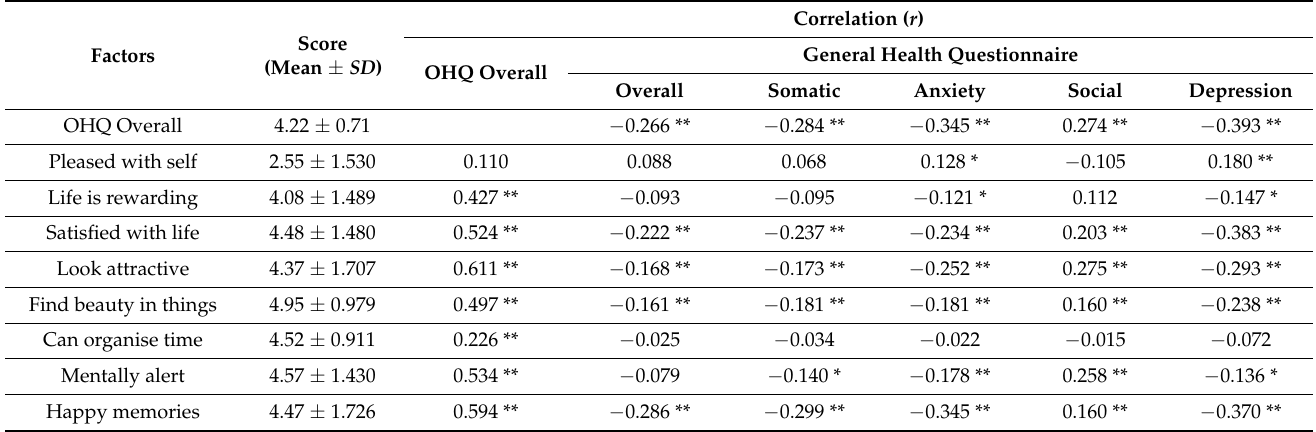
Table 4. Happiness scores as related to mental